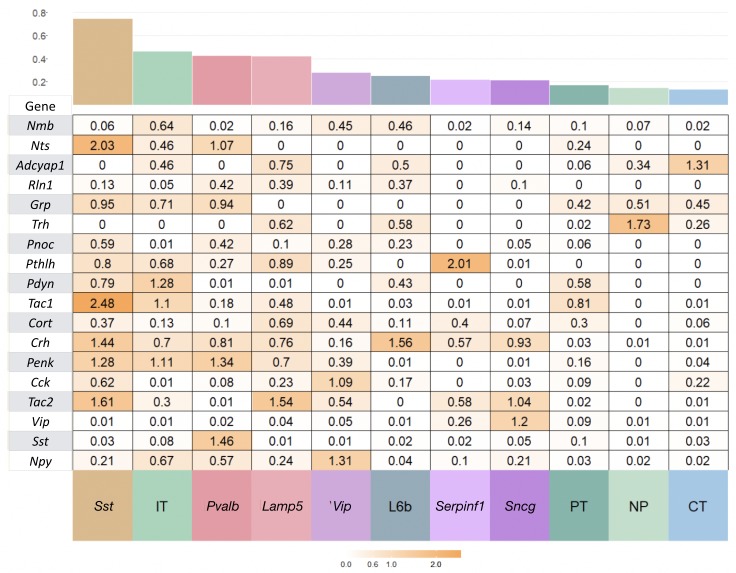
NPP expression variation within subclasses.Coefficient of variation (c.v. = standard deviation/mean) of expression for each NPP gene for Tasic et al., 2018 cell types pooled to 12 major types, glutamatergic types (IT, PT, NP, CT, L6b) and GABAergic types (Lamp5, Sncg, Serpinf1, Vip, Chodl, Sst, Pvalb). Chodl does not appear in the figure here or in main text as there is only one Tasic cell type in this class. The type types are sorted from left to right in decreasing average c.v. The variability is a substantial fraction of the global variation across all types indicating complex combinatorial expression patterns at the level of the Tasic et al ontology and the need to consider this level of resolution. Outlier genes are colored more orange and examples labelled in Figure 3 of the main manuscript. Mean c.v is shown in the barplot on top.